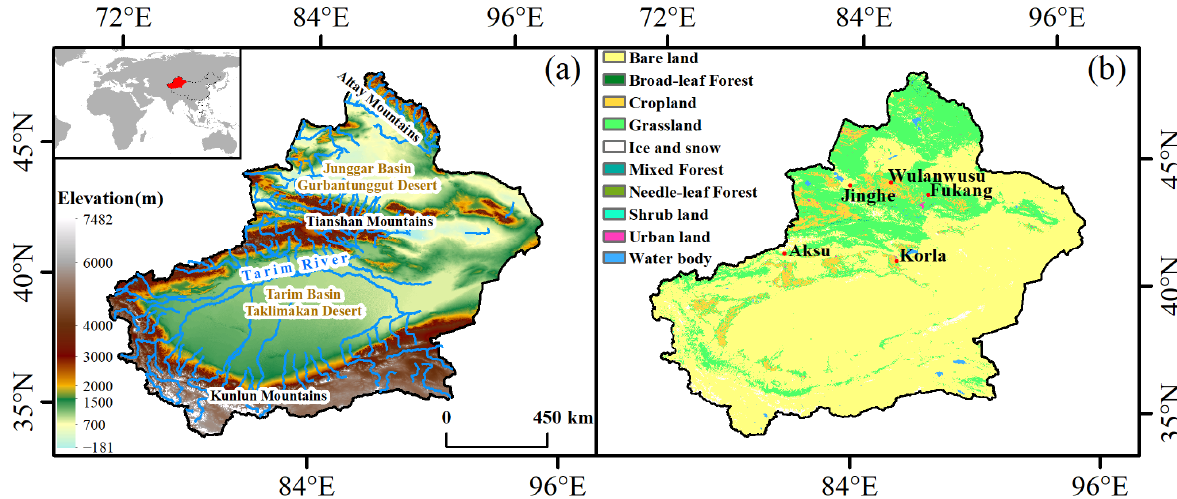
Figure 1. Digital elevation model (DEM) ( a ) and the studied observation sites on top of land cover maps in Xinjiang ( b ). Note: The five observation sites are Wulanwusu, Fukang, Jinghe, Korla, and Aksu stations.